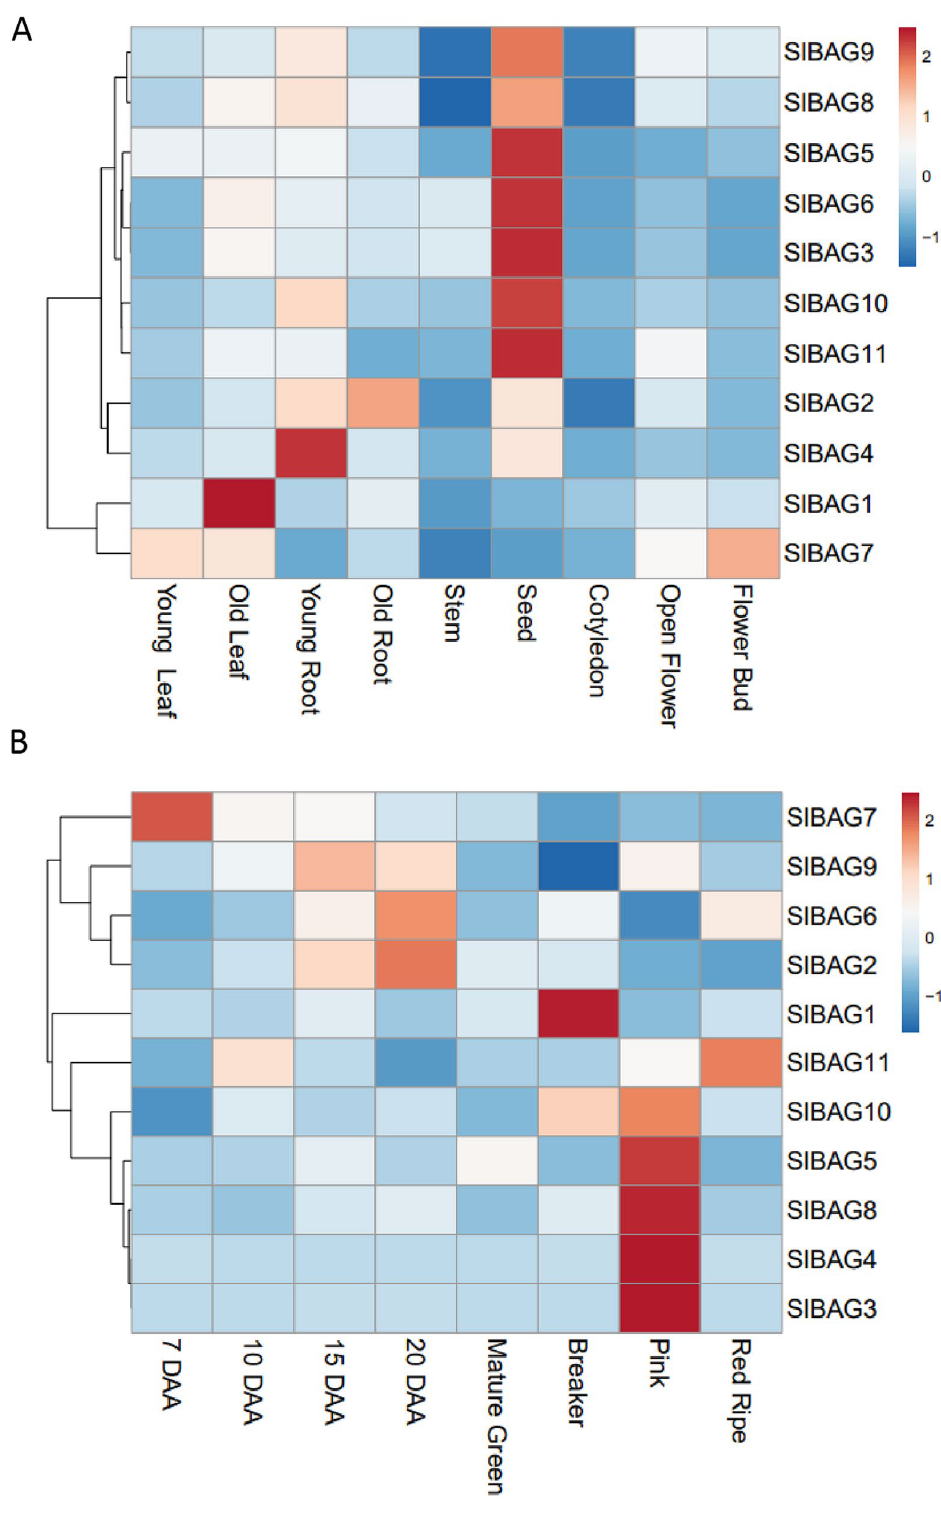
Figure 3. Tissue specific expression analysis of SlBAGs performed using qRT-PCR. Transcript accumulation of SlBAGs was measured by qRT-PCR using tomato actin as endogenous control. qRT-PCR data was used to make a heat map for displaying gene expression using clustvis tool (https:// biit. cs. ut. ee/ clust vis/) 48 . ( A ) Heat map showing SlBAGs expression during different plant tissues ( B ) Heat map showing SlBAGs expression during fruit developmental and ripening stages. After tagging flowers at anthesis, fruits were harvested at 7 to 20 days after anthesis (DAA), mature green, breaker, pink and red ripe stages of fruit development and ripening. Each qRT-PCR reaction was performed with three independent biological replicates, each consisting of three independent technical replicates. The 2 −ΔΔCT method for analyzing the qRT-PCR data was employed. The values were converted to log2 fold change in expression before making the heat